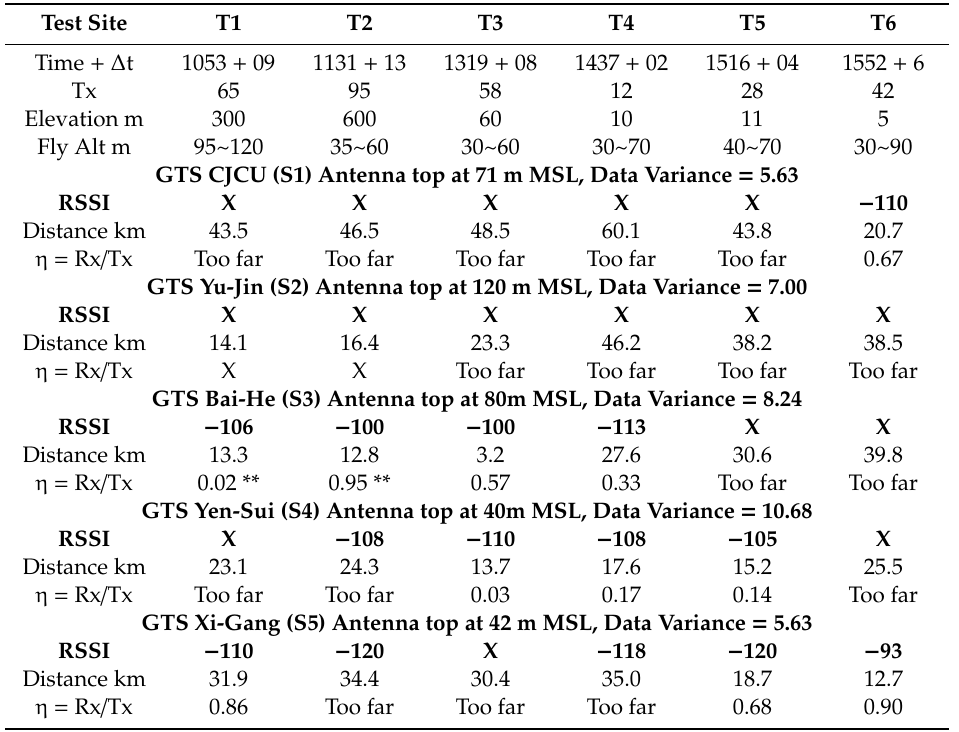
Table 6. Flight test data